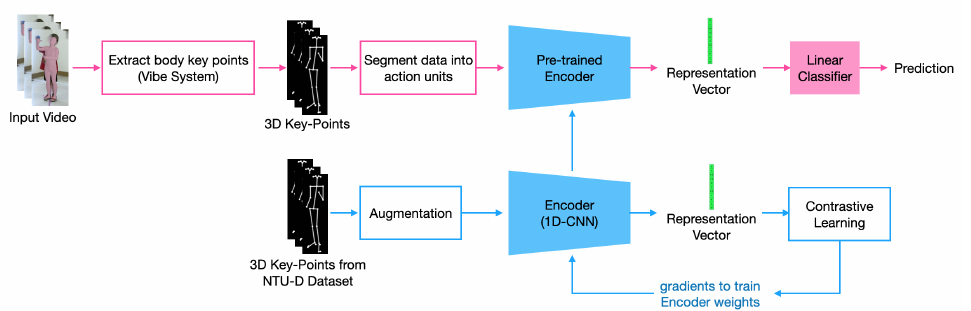
Figure 1. Proposed method architecture: top (pink)—supervised classification; bottom (blue)—self- supervised